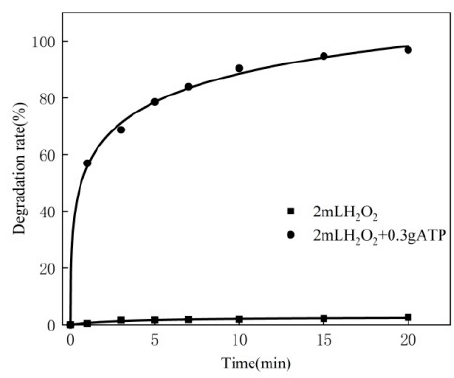
Figure 10. Experimental results of H 2 O 2 .